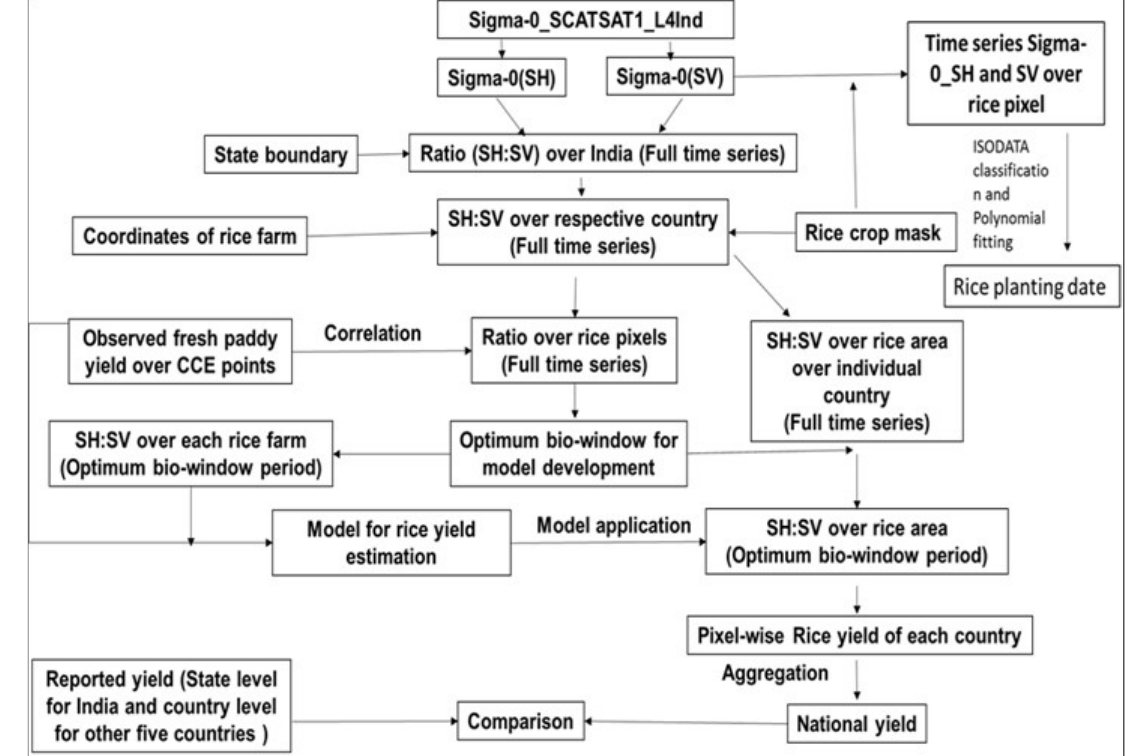
Figure 2. Approach and methodology for rice yield prediction with SCATSAT-1